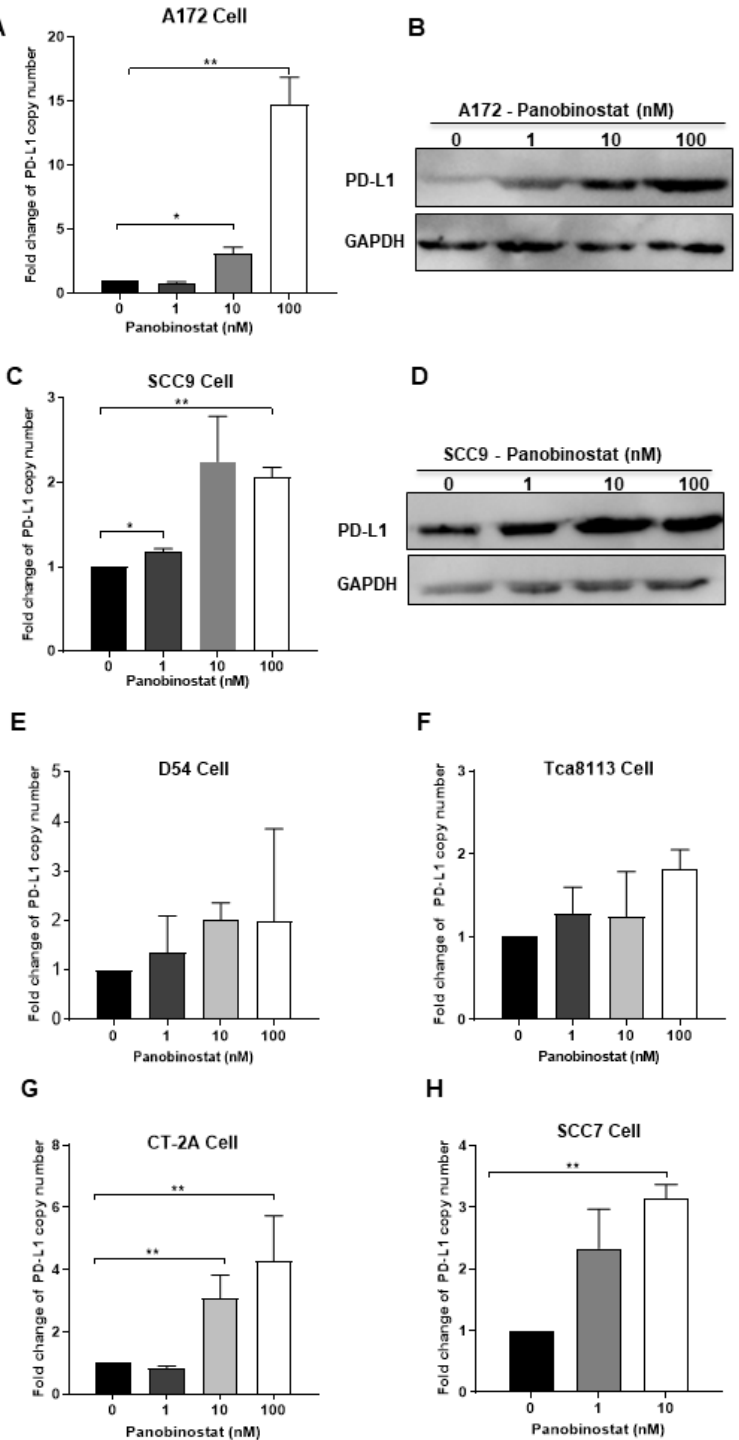
Figure 5. Panobinostat treatment upregulated the PD-L1 expression in glioma and squamous cell carcinoma cells. A172 ( A , B ), SCC9 ( C , D ), D54 ( E ), Tca8113 ( F ), CT-2A ( G ), or SCC7 ( H ) cells were mock-treated or treated with panobinostat at different concentrations of 1, 10, or 100 nM for 14 h, respectively. Then, the cell pellets were harvested. For each condition, half of the cell pellets were used for total RNA extraction, following reverse transcription to cDNA. The other half of the cell pellets were lysed and used for Western blot (WB) as described in the Materials and Methods section. The assay was performed in triplicate. Differences between datasets were assessed by Student’s t -test (two-tailed) using GraphPad Prism software. * p < 0.05, ** p <